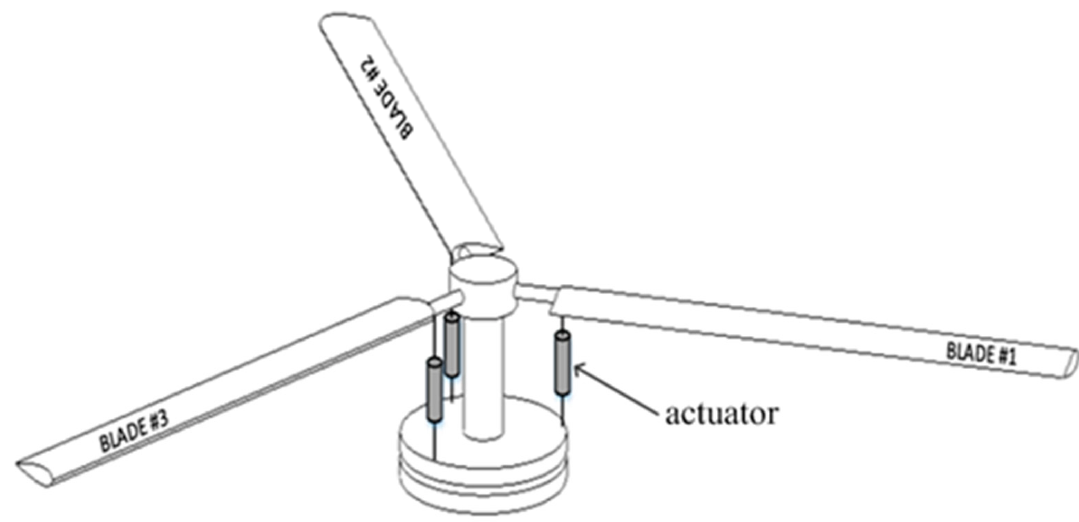
Figure 1. Helicopter individual blade control.